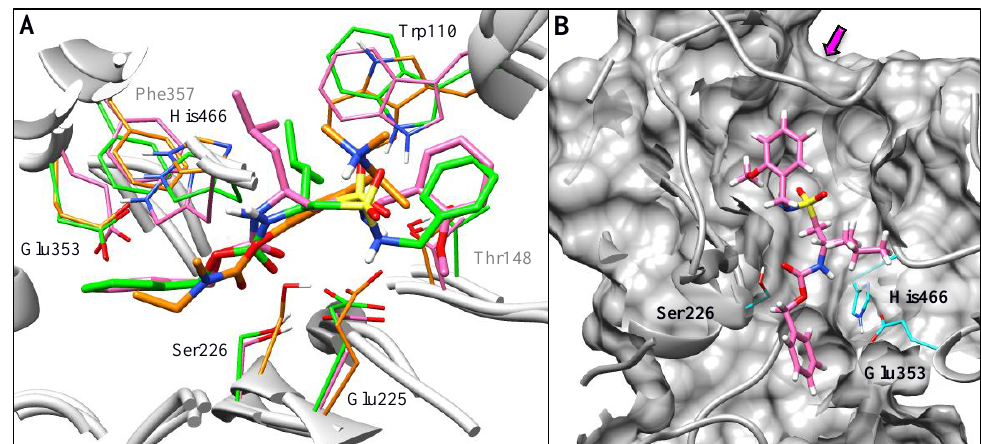
Figure 2. ( A ) Spatial view of BChE- 5c (green), BChE- 5k (pink) and BChE-RIV (orange) overimposed for comparison; ( B ) Active site of Equus caballus BChE when complexed with compound 5k (pink).